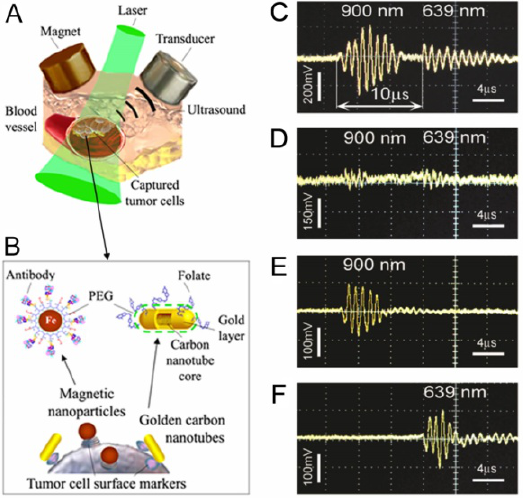
cells that contained a higher local MNP concentration or dense MNP clusters. As a result, labeled cells were captured effectively up to flow velocity of 5–10 cm/s while free MNPs were captured only at low velocity of 0.3–0.5 cm/sec (Figure 18A). Figure 17. In vivo magnetic capture and two-color PA detection of breast CTCs. ( A ) Schematic showing the detection method. The laser beam is delivered either close to the external magnet or through a hole in the magnet with a fiber-based delivery system. ( B ) Schematic of targeting breast CTCs with MNPs (a 10 nm core, a 2 nm layer of amphiphilic triblock copolymers, and the ATF of the uPA and GNTs (12 nm × 98 nm) coated with PEG and folic acid. ( C – F ) Typical PA signals at different wavelengths from CTCs labeled with MNPs and GNTs ( C ), GNTs only ( D ), and MNPs only ( E ). ( F ) PA signals from blood vessels only [81].